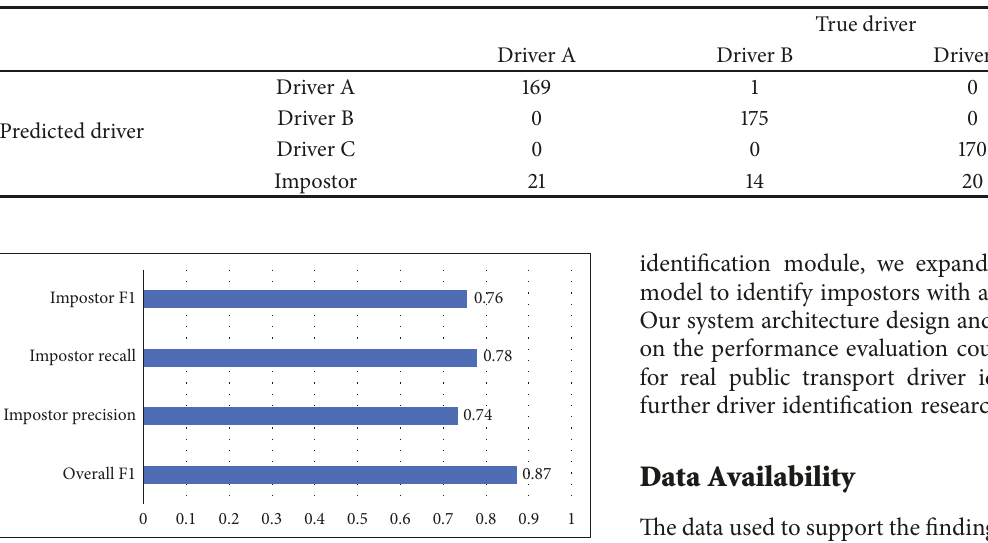
Table 4: Summation of the confusion matrix from 10-fold cross validation in the impostor detection experimentwhen utilizing the K-nearest neighbors.